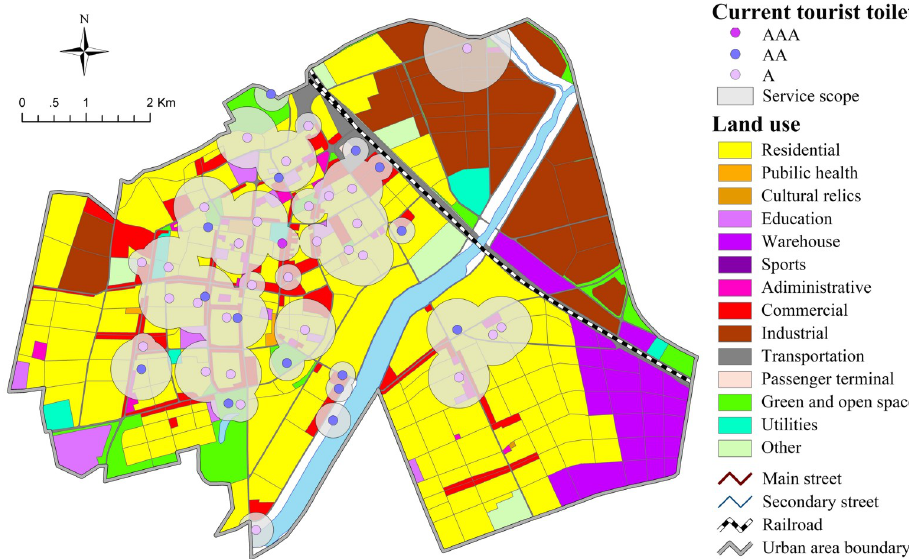
Fig 6. Service scope of current toilets in context of land use (copyright hold by the